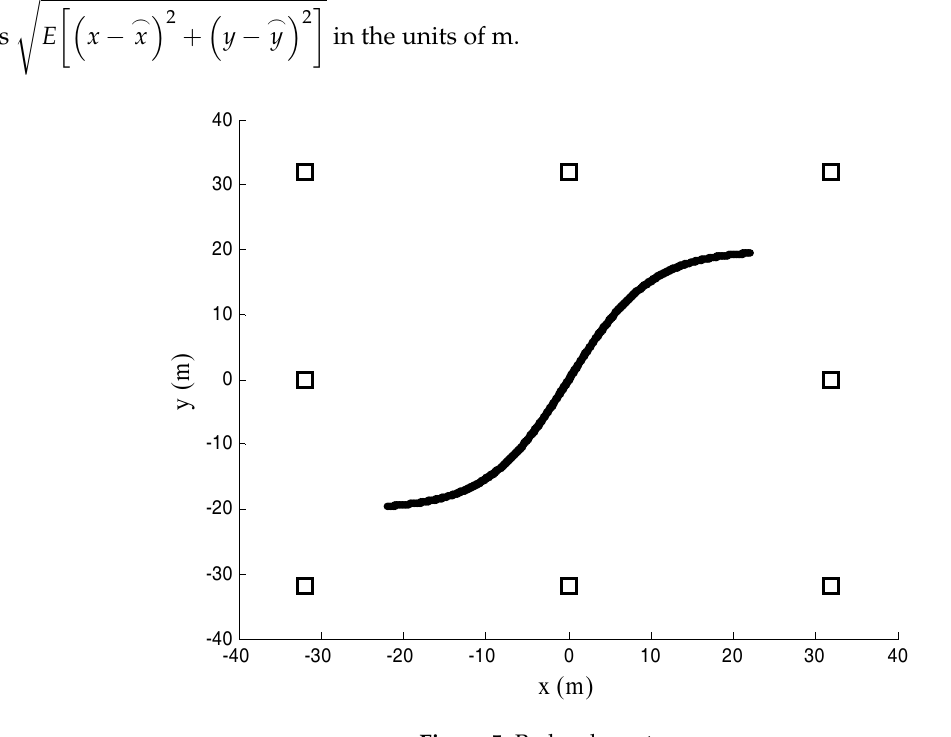
Figure 5. Radars layout.